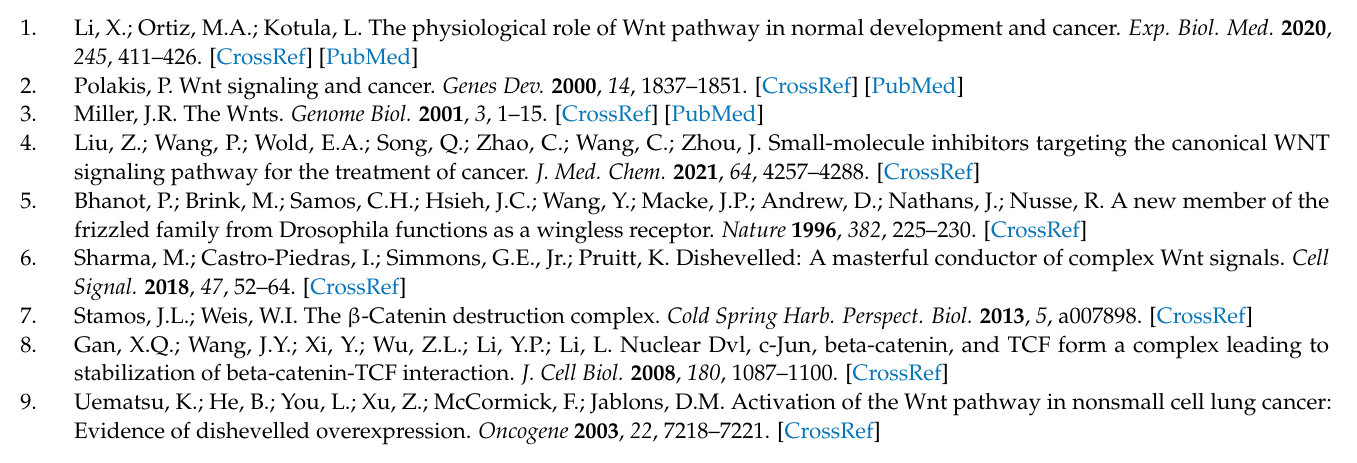
Figure S2, Enantio separation of racemate 1; Figure S3, Snapshot of the compound ( S )- 1 with DVL1 PDZ trajectory; Figure S4, Snapshot of the compound ( R )- 1 with DVL1 PDZ